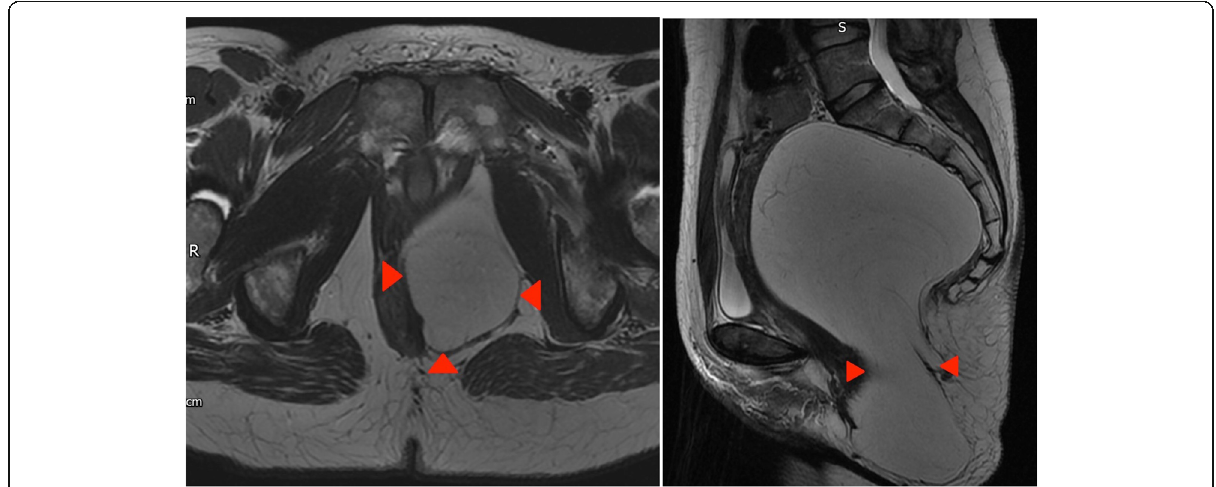
Fig. 13 Left panel: Axial T2-weighted MR of the pelvis: arrowheads outline a fatty mass in the left ischiorectal fossa. Right panel: Sagittal T1- weighted MR image of the pelvis: large fatty pelvic lesion seen with extension through the left ischiorectal fossa into the perineal tissues. Arrowheads outline the level of the ischiorectal